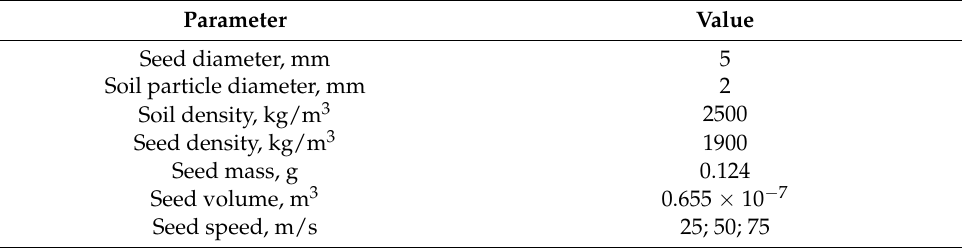
Table 6. Simulation parameters the impact interaction of seeds with the soil environment.